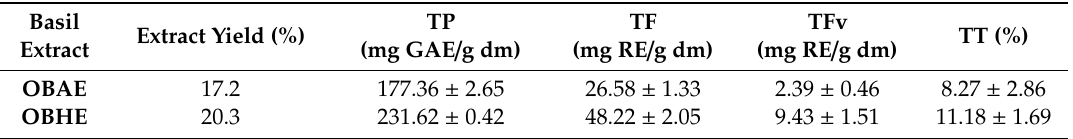
Table 1. Total content of various phytocompunds classes from basil hydro-alcoholic extracts analyzed by spectrophotometric